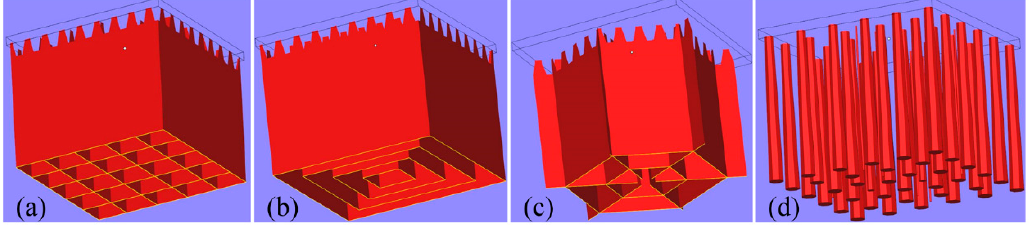
Figure 1. Conventional designs of support structures: ( a ) block support; ( b ) contour support; ( c ) web support; and ( d ) cone support.